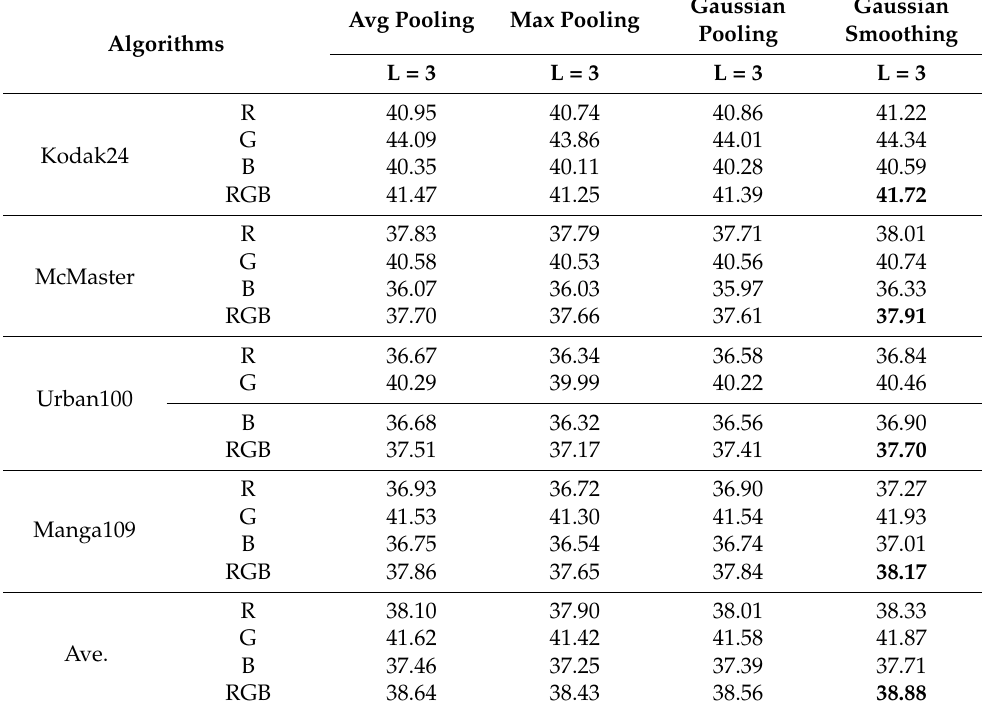
Table 6. Testing results on four datasets for network structures with different pooling layers. Only the results for the L 3 network are presented here for clearer comparisons of different network structures. Gaussian Gaussian Avg Pooling Max Pooling Pooling Smoothing Algorithms L =